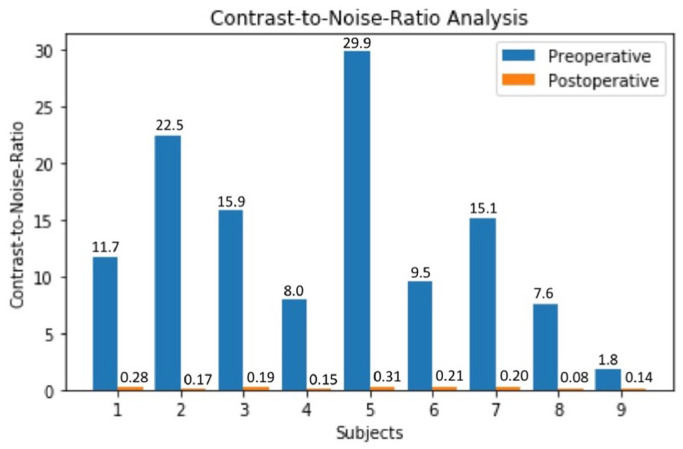
Results of the pre and post-operative contrast-to-noise analysis across subjects, subject 5 scanned pre-operatively at 1.5 T.